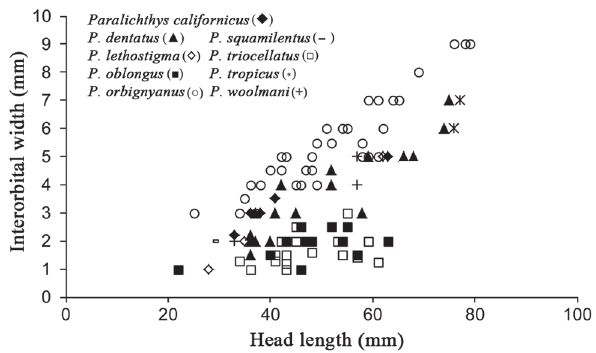
Fig. 8. Relationships of interorbital width to head length in Paralichthys californicus , P. dentatus , P. lethostigma , P. oblongus , P. orbignyanus , P. squamilentus , P. triocellatus , P. tropicus and P. woolmani .